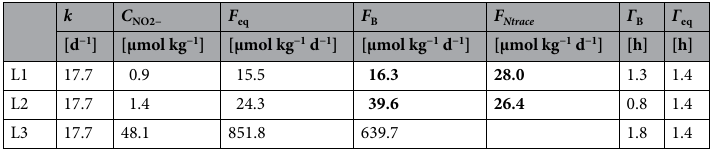
Table 3. Nitrite transformation fluxes (due to equilibration ( F eq ) and biological turnover ( F B )) and residence time due to biological turnover ( Γ B ) or abiotic equilibration ( Γ eq ) determined with δ 18 O NO2 - values compared to nitrite turnover rate determined with Ntrace model ( F Ntrace